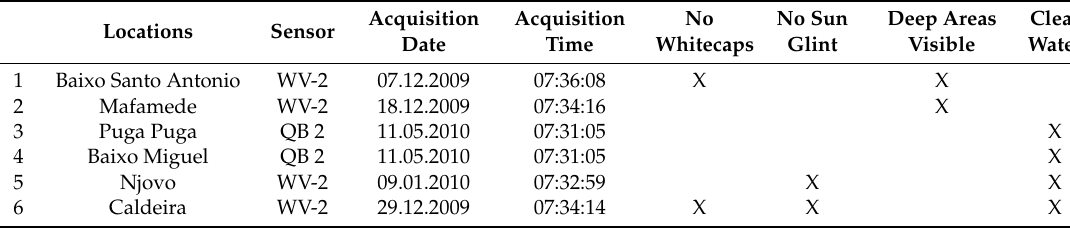
Table 1. Sensor, acquisition date and time and visibility assessment for the imagery covering each location.